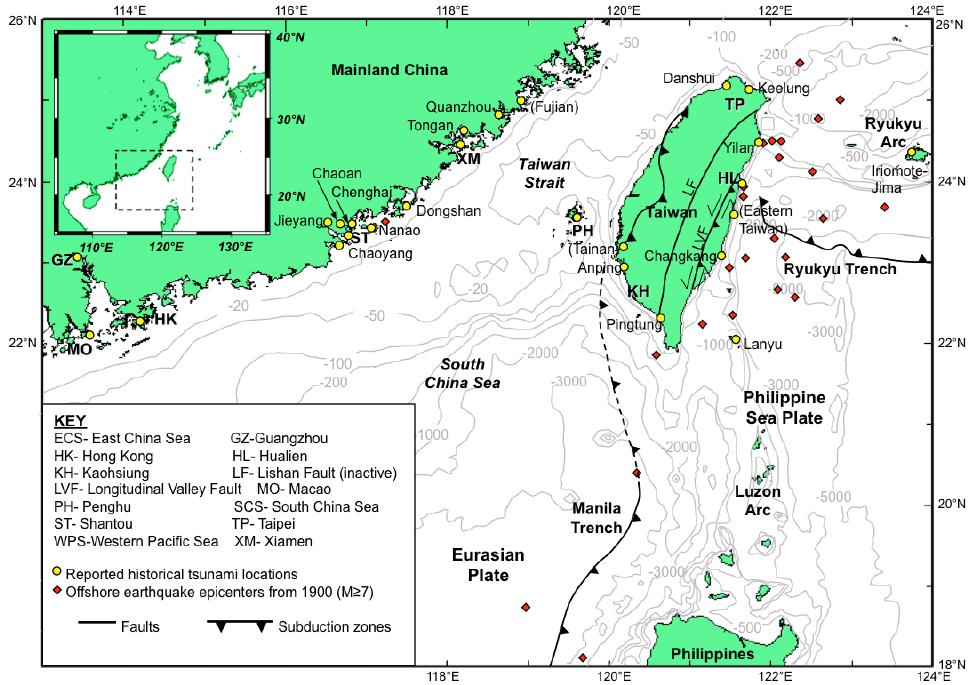
Fig. 1. Map of the NE South China Sea and surrounding regions. Locations of main cities are denoted with abbreviated names. Reported places affected by historical tsunamis are marked with yellow circles along with full names. Names in brackets represent the less defined locations, for which the locations marked with yellow circles may not be the exact part of coast affected due to the lack of details reported. (Bathymetry modified from Jan et al., 2002, and NGDC, 2009a; tectonics adapted from Shyu, 2006; earthquake epicenters data adapted from Zhang, 2002, and NGDC,